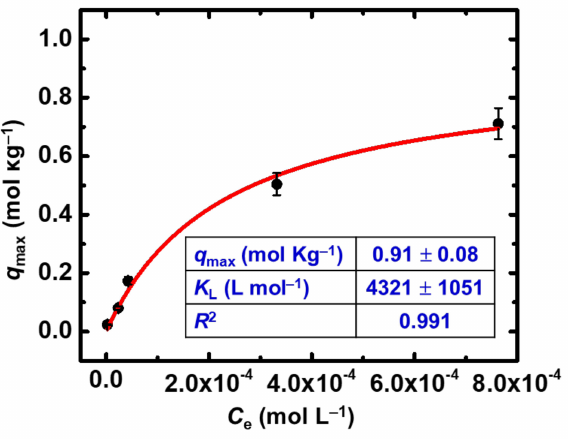
Figure 6. Experimental data and Langmuir sorption isotherm of Th(IV) on X-alginate aerogels at